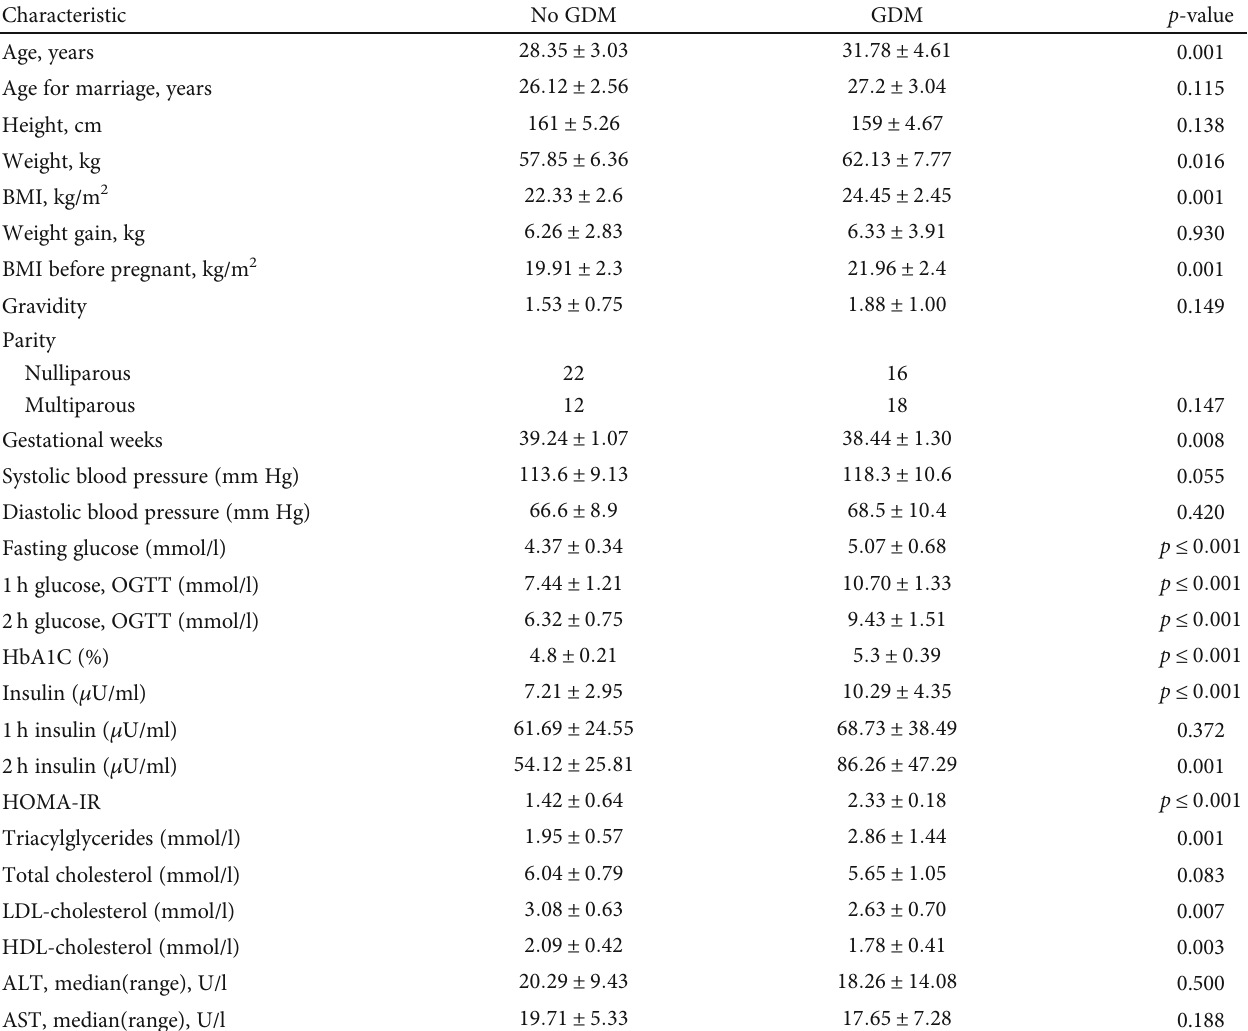
Table 1: General characteristics of study